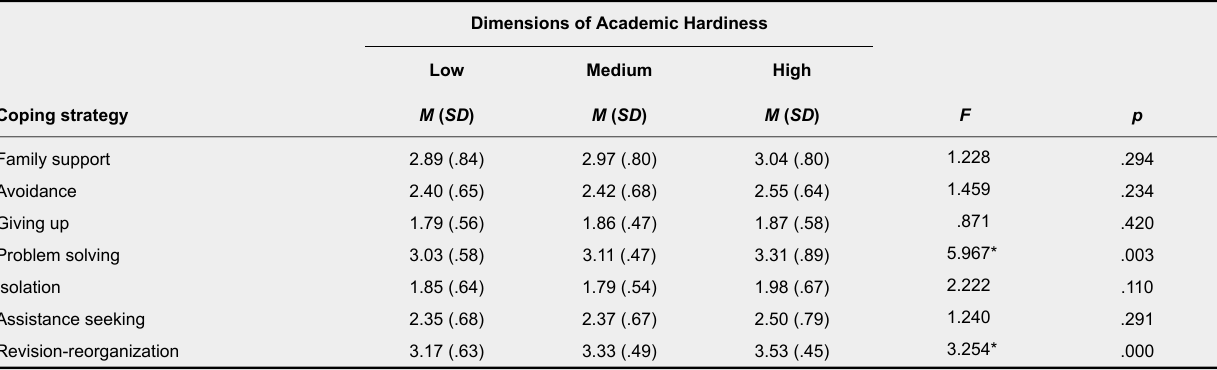
One-Way ANOVAs’ Results for the Relation Between Different Scores of the Dimensions of Academic Hardiness and Coping Strategies. Dimensions of Academic Hardiness